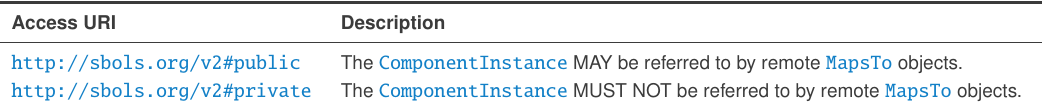
Table 5: REQUIRED URI s for the access